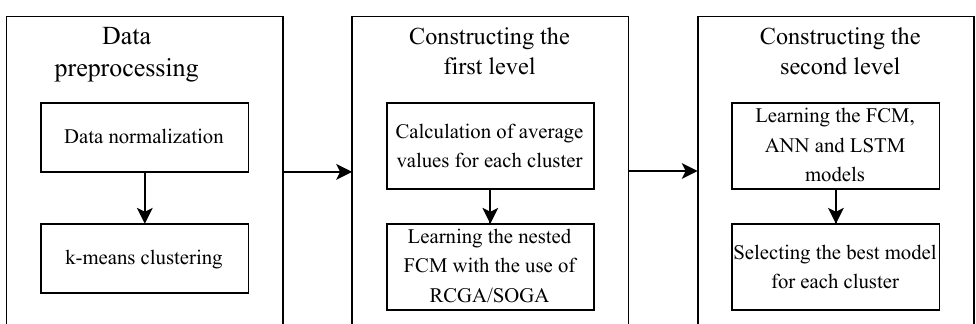
Figure 1. Example of a nested structure.